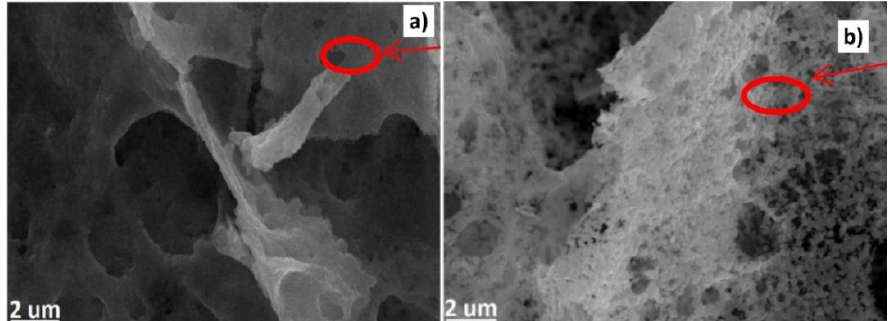
Figure 32. SEM images of doped ZnO: ( a ) 15% Co doped ZnO, ( b ) 15% Cr doped ZnO. Reprinted